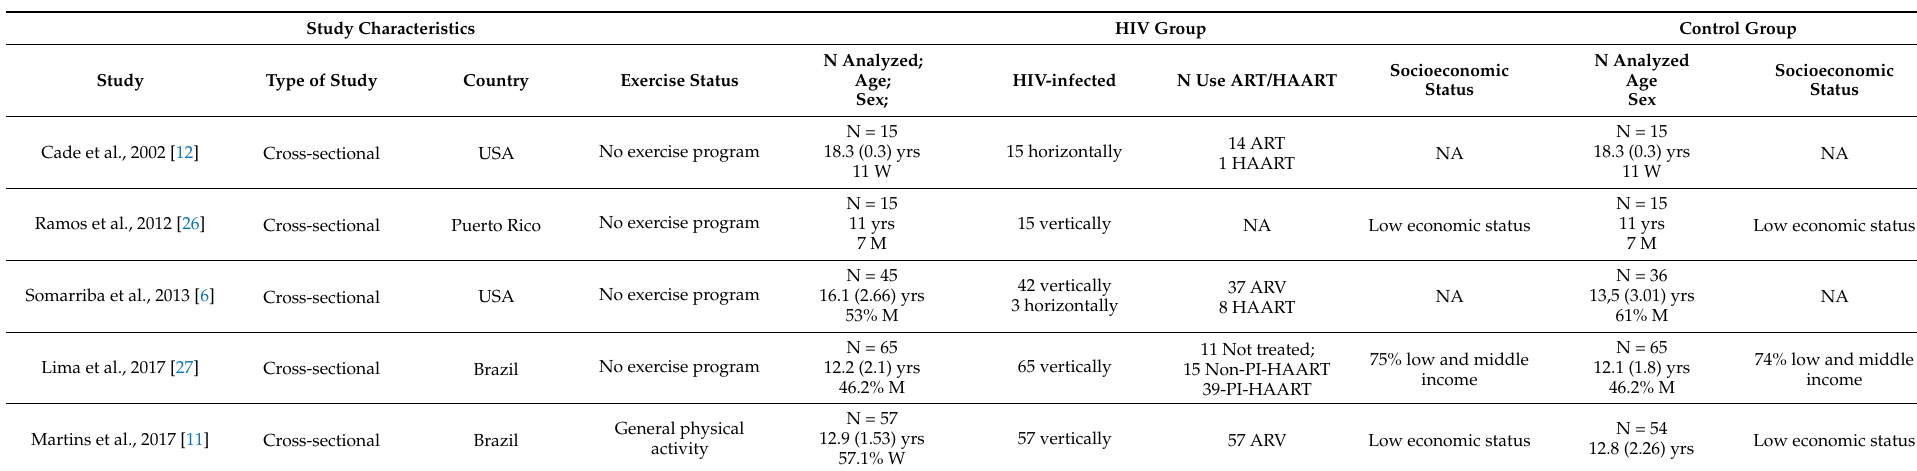
Table 1. Characteristics of the studies included in the review.